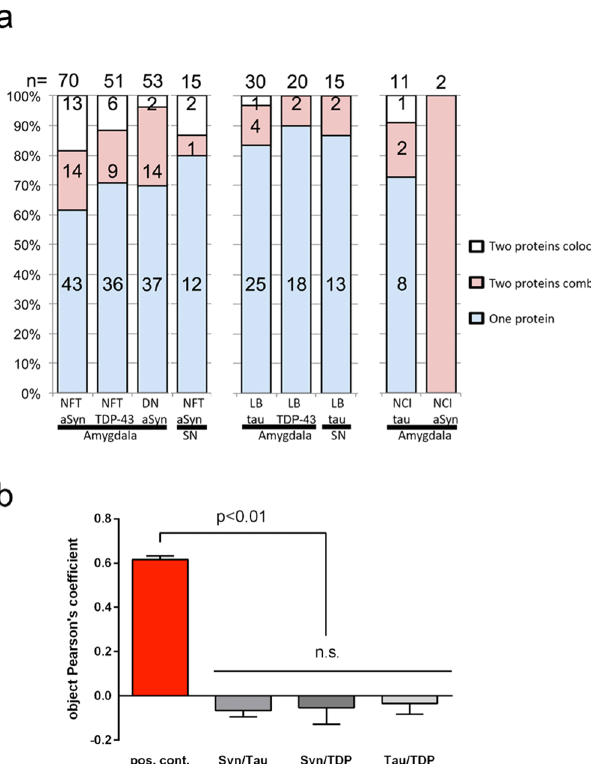
Figure 2. Comparison between conventional colocalization assessment and novel image analysis techniques. ( a ) Conventional assessment showing number (n) and percentage (%) of neuronal protein inclusions in different diseases in the amygdala and substantia nigra (SN). Lewy bodies (LB), neurofibrillary tangles (NFT), and TDP-43 positive neuronal cytoplasmic inclusions (NCI) were counted and the labels “one protein”, “two proteins combined” or “two proteins colocalizing” were given. Accumulations are grouped according to their primary protein and each column represents a combination with another protein. LB, α -Syn positive Lewy body; NCI, TDP-43 positive neuronal cytoplasmic inclusion; NFT, pTau positive neurofibrillary tangle; SN, substantia nigra. ( b ) Novel colocalization and FRET evaluation. Double stainings of α -synuclein/pTau (Syn/ Tau), Syn/TDP and Tau/TDP have been analyzed with our new ImageJ macro and Pearson’s coefficient have been calculated for identified objects. A double Tau-staining served as positive control (Error bars represent SEM; Syn/Tau: n = 95; Syn/TDP: n = 16; TDP/Tau: n = 46; positive control (Tau/Tau): n = 185). Graphpad Prism ™ . ANOVA and Bonferroni post-testing revealed that the positive control differed significantly (p < 0.01) from the other stainings, but that the latter showed no significant difference between each other